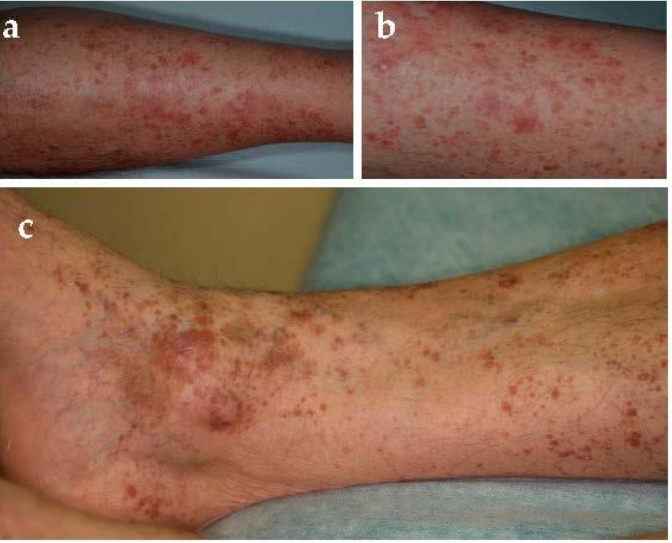
Figure 4. Pigmented purpuric lichenoid dermatitis of Gougerot and Blum. ( a – c ). Purpuric red-brown lichenoid papules on lower extremities.